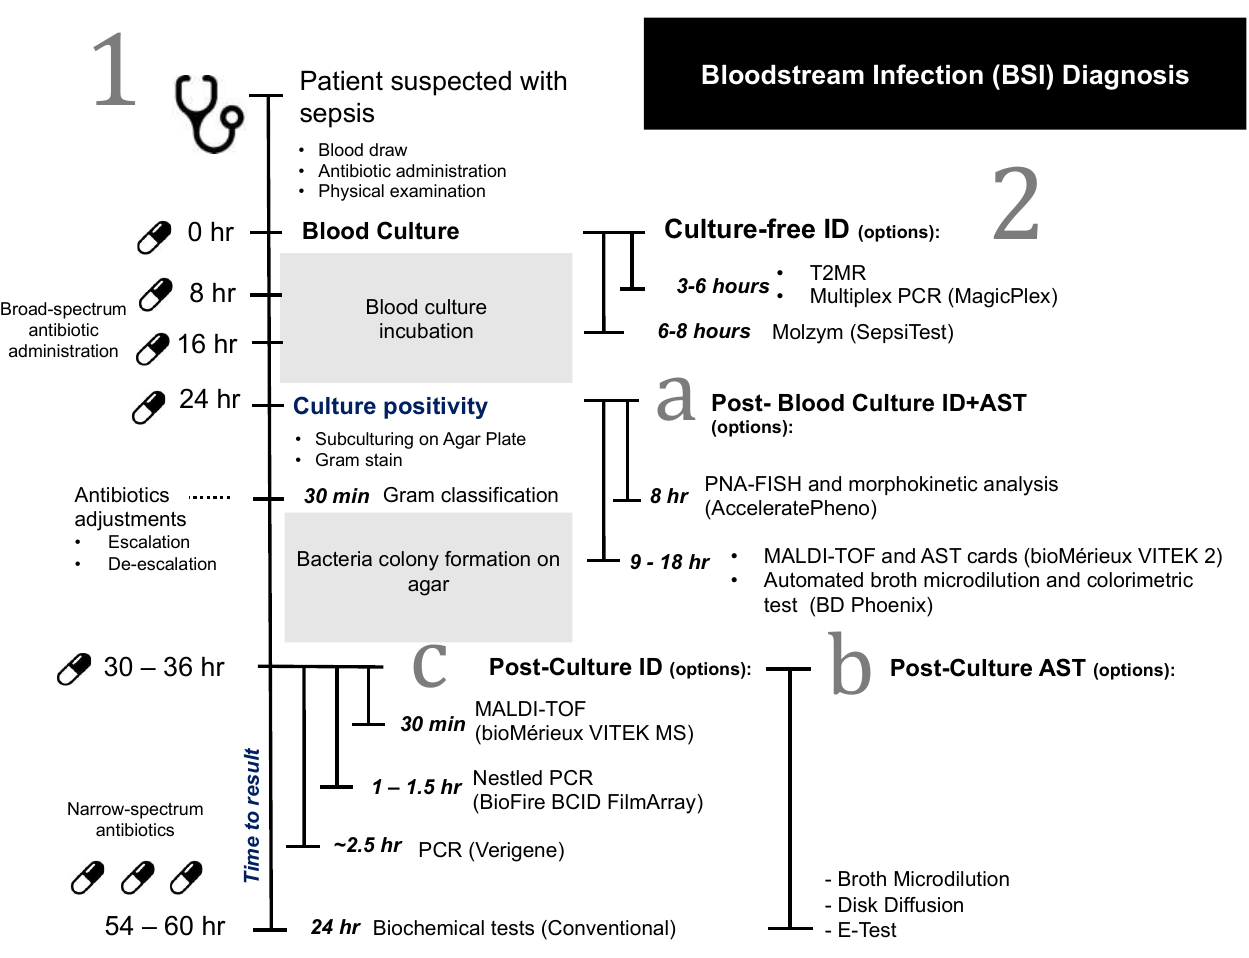
Figure 1. Workflow of current BSI diagnosis. (1) Blood collected from patients is subject to culturing followed by either an all-in-one post-culture ID/AST (a) or post-culture ID with a separate AST (b + c). (2) Culture-free ID workflow is also currently available with a separate AST from positive culture. Antibiotics administration at the point of examination. Antibiotic choices may be adjusted accordingly.